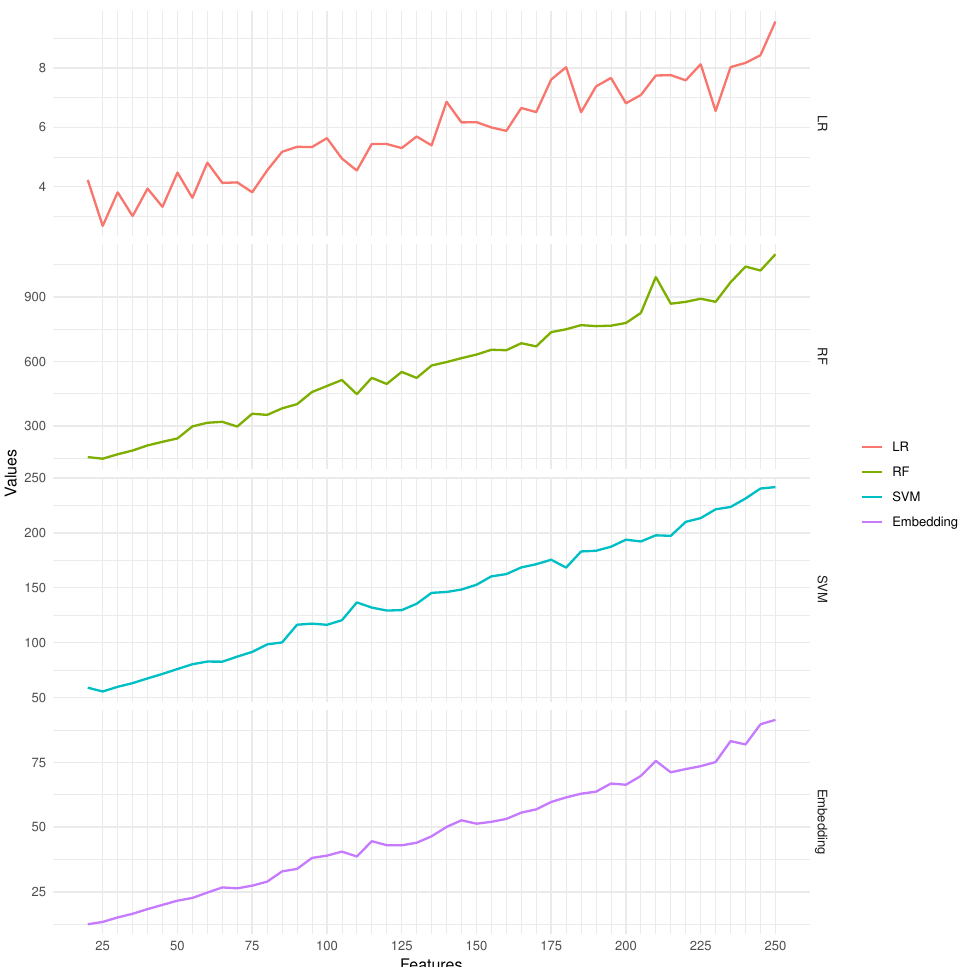
Figure 7. The execution time for the embedding process and the training time for logistic regression (LR), random forest (RF), and support vector machines (SVMs).